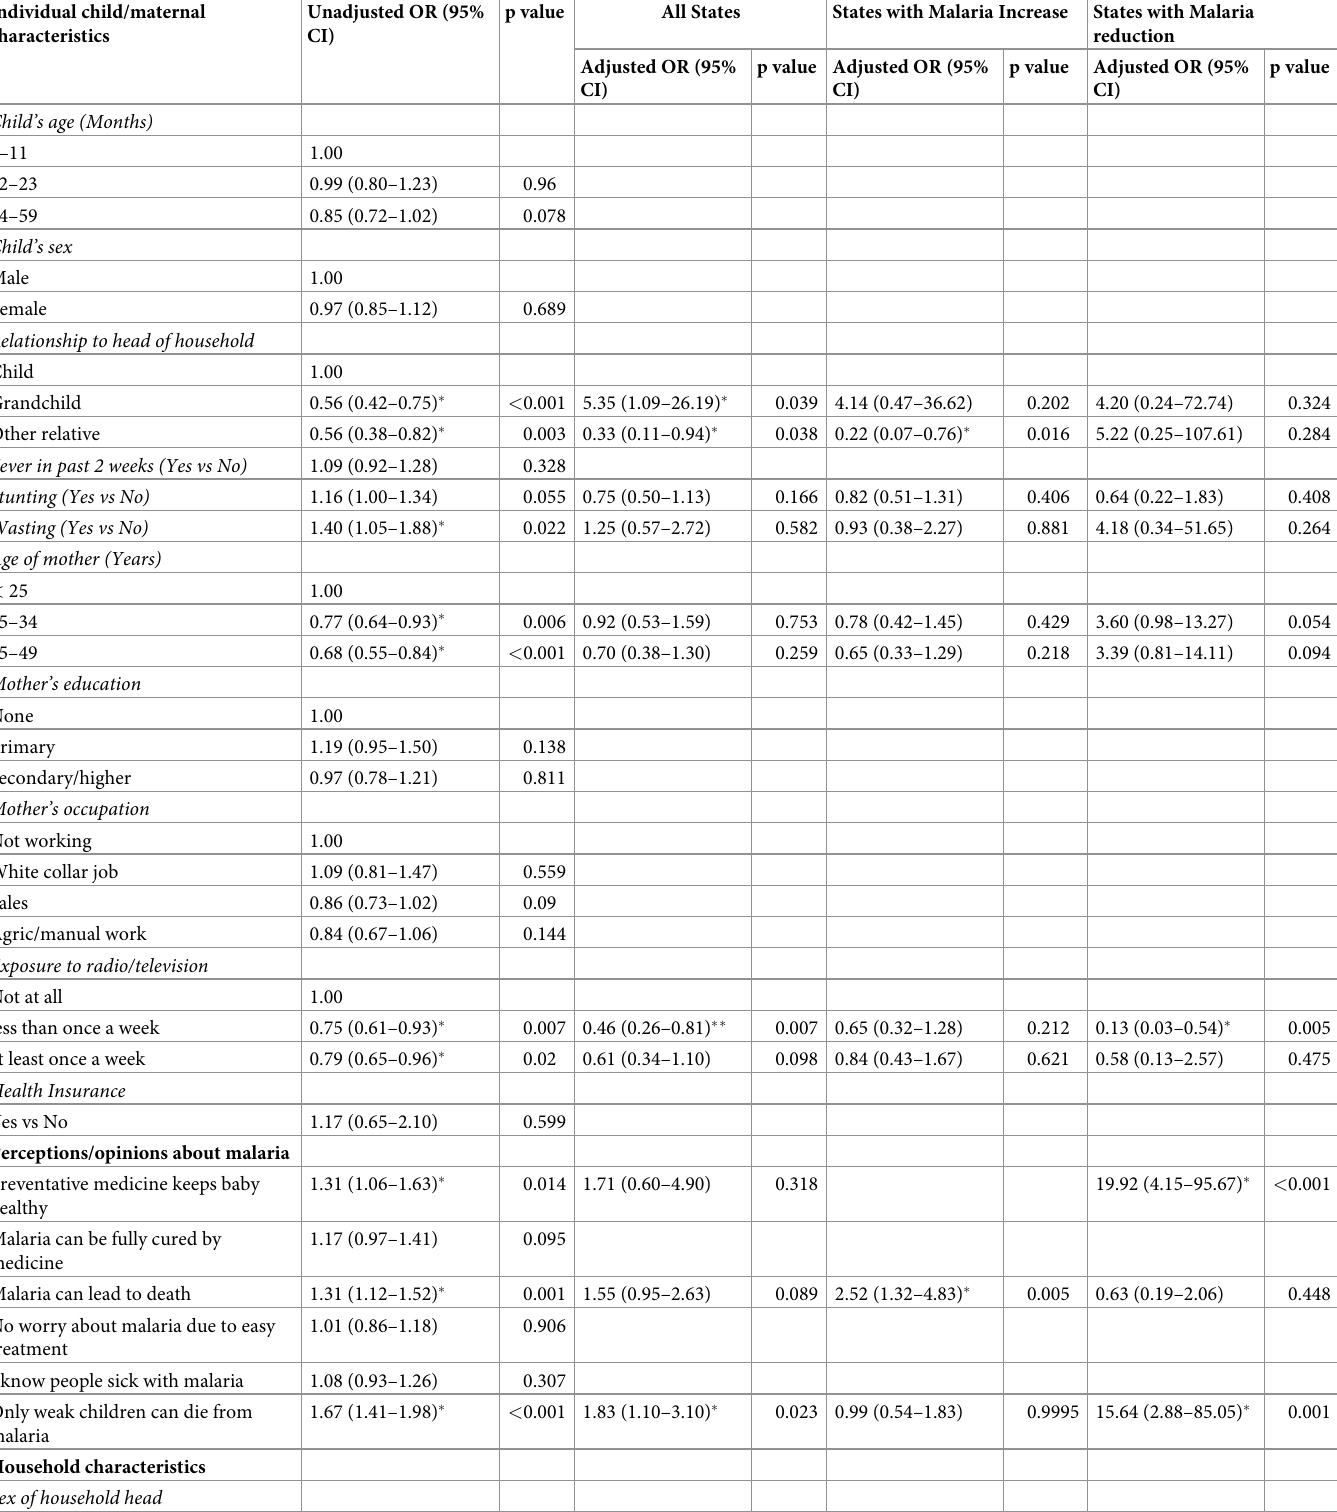
Table 5. Factors associated with LLIN utilisation among under-5 children in 13 selected States, Nigeria (NDHS 2018). Individual child/maternal